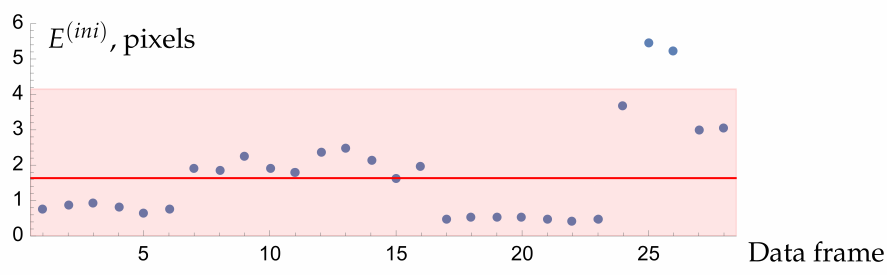
( ini ) Figure 7. Residual per-pose values E of Equation (10) for the model A calibrated over all 29 frames i in the dataset 0. The red line indicates the median of all values and the shaded region denotes the acceptance bounds according to the modified Z-score method with the threshold of